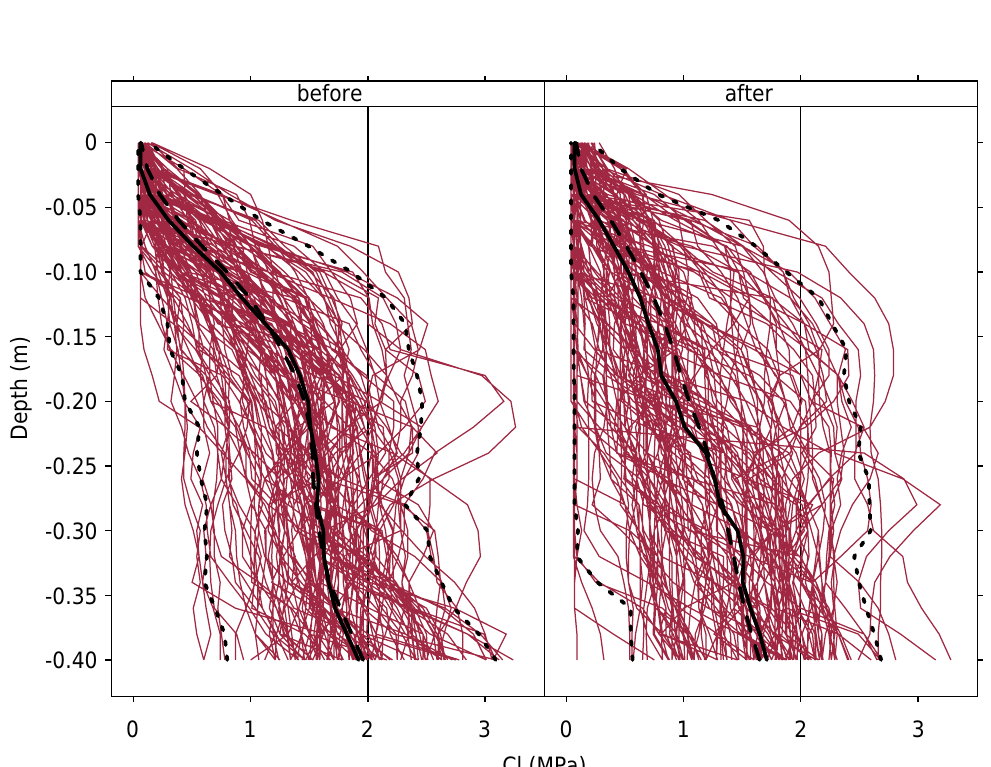
Figure 2. Spaghetti plots showing the variability of vertical profiles of cone index (CI) in MPa (gray lines) before and after tillage. Black lines represent the mean (solid line), median (dashed line), and the 2.5th and 97.5th quantiles (dotted